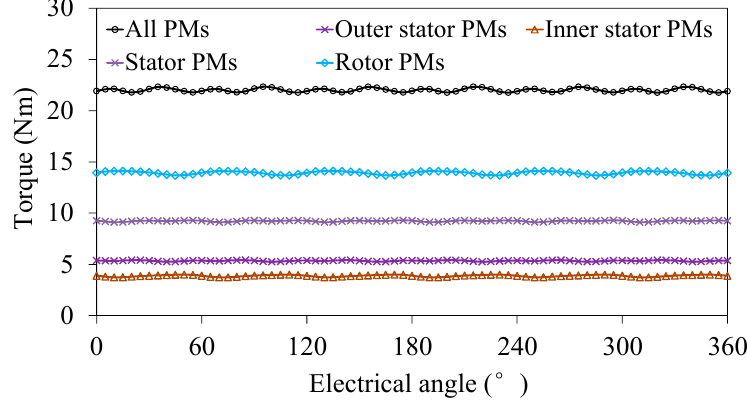
Figure 14. Steady torque with different excitation sources.